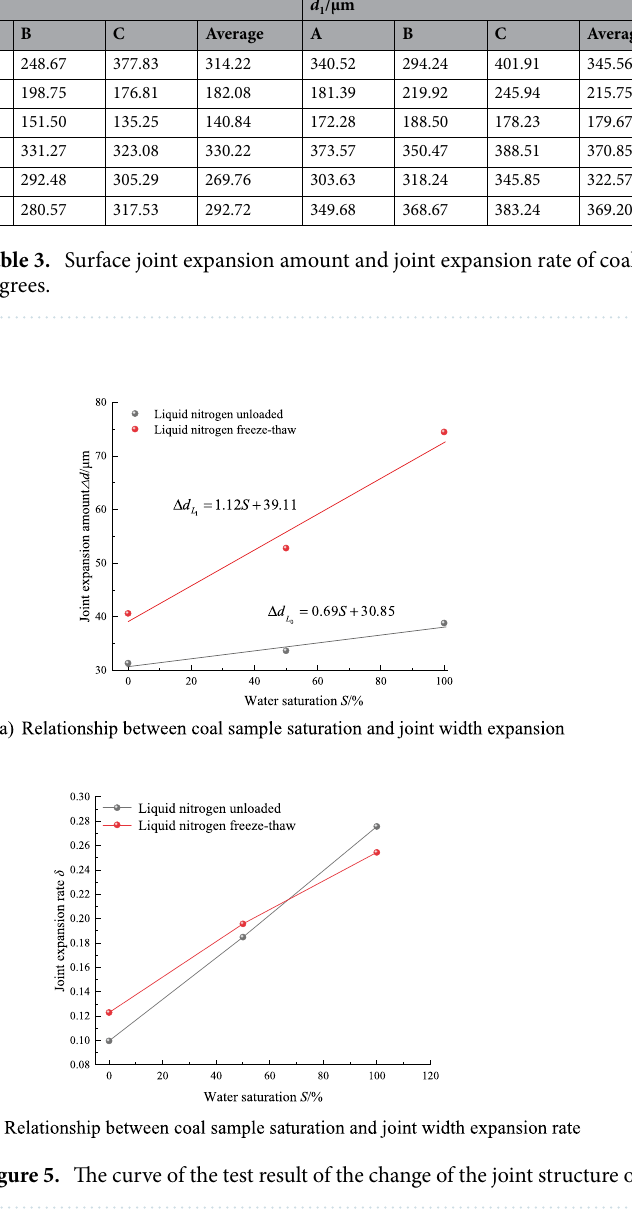
Figure 5. The curve of the test result of the change of the joint structure on the surface of the coal